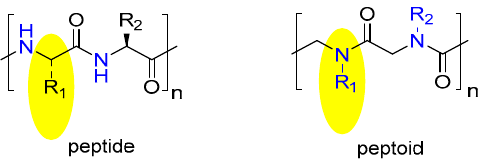
Figure 2. Comparison of peptide and peptoid structures.